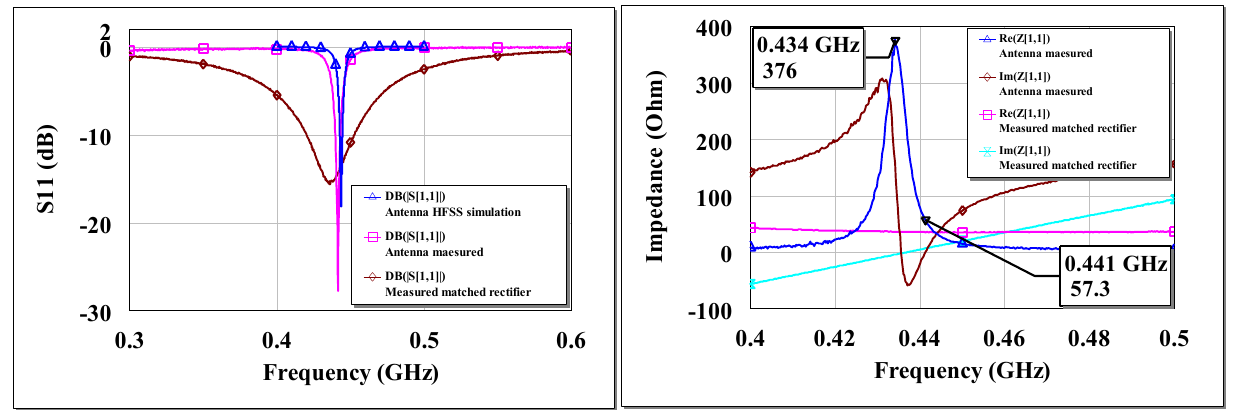
Figure 18. Antenna HFSS simulated, antenna measured, and measured L-matched diode rectifier S on a Duroid 5880 PCB for −30 dBm input ( left ), Measured open circuit input 11 impedance of antenna and rectifier at −30 dBm input ( right